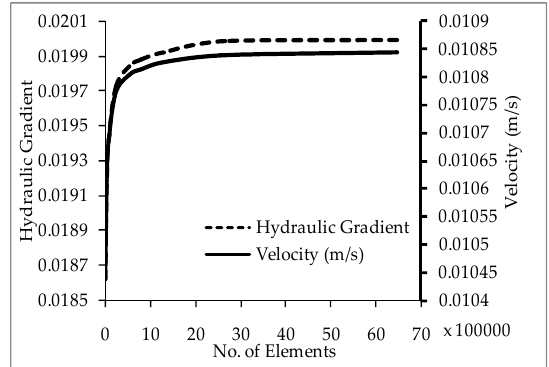
Figure 5. The variation of the pressure drop with different mesh sizes.